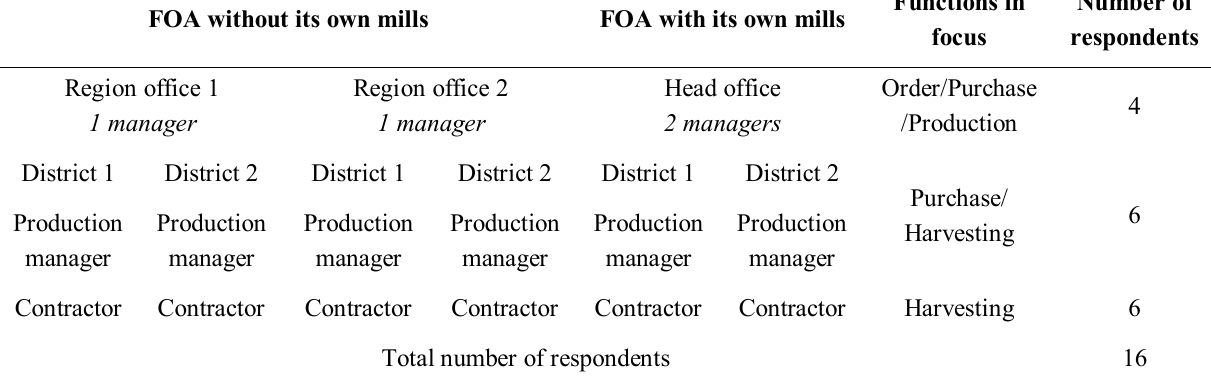
Table 1. Distributed number of respondents between the two studied forest owners associations (FOAs).